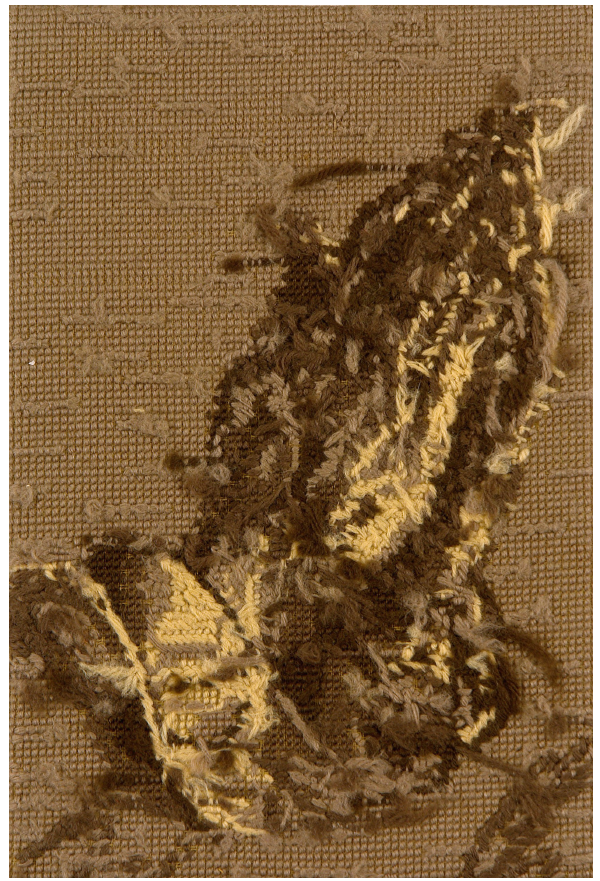
Figure 6: Rob Scholte: Praying Hands